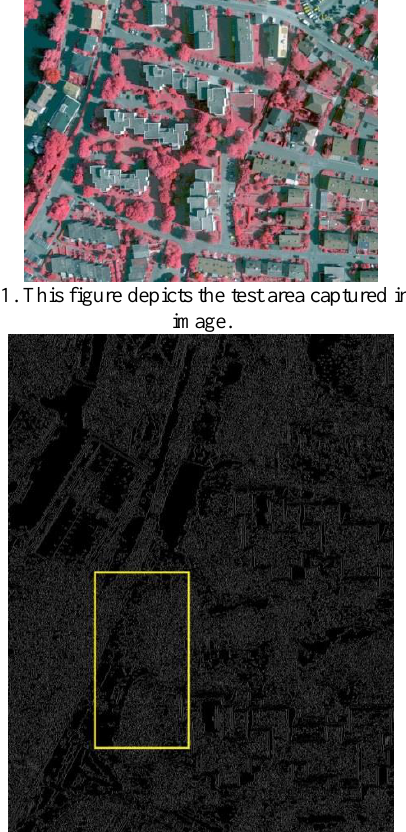
Figure 2. This figure shows the outline of image segmentation on the original image after converting the original image to greyscale. The area in the yellow box is part of road that is in the shadow. As it can be seen the vehicle in the shadow is not recognisable.